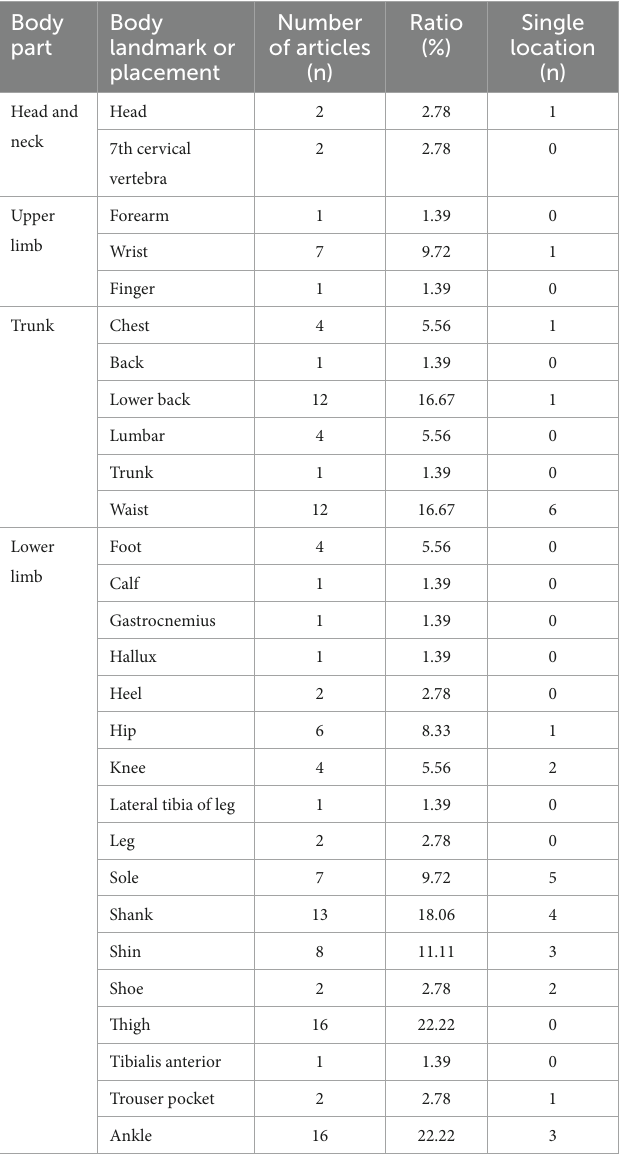
TABLE 3 Summary of device location of FOG detection studies. Body Body part landmark